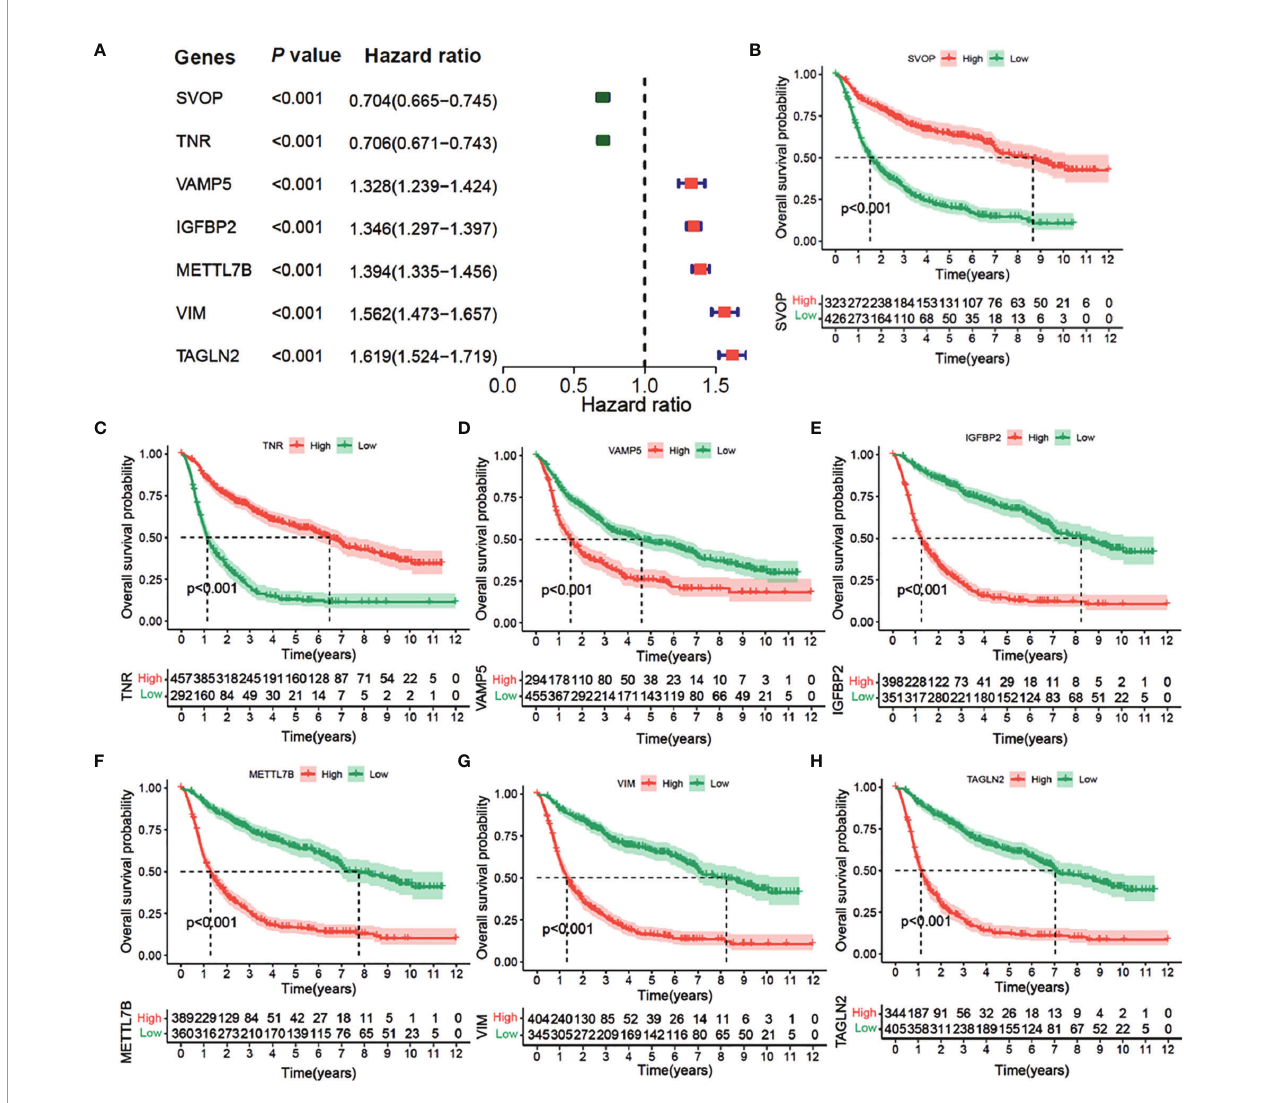
FIGURE 7 | Univariate Cox Forest plot and Kaplan – Meier survival analysis of 7 hub genes in CGGA cohort. (A) Univariate Cox Forest plot of 7 immunity-subtype- related genes. (B) Kaplan – Meier curve survival analysis of 7 hub genes, (B) SVOP, (C) TNR, (D) VAMP5, (E) IGFBP2, (F) METTL7N, (G) VIM, (H)